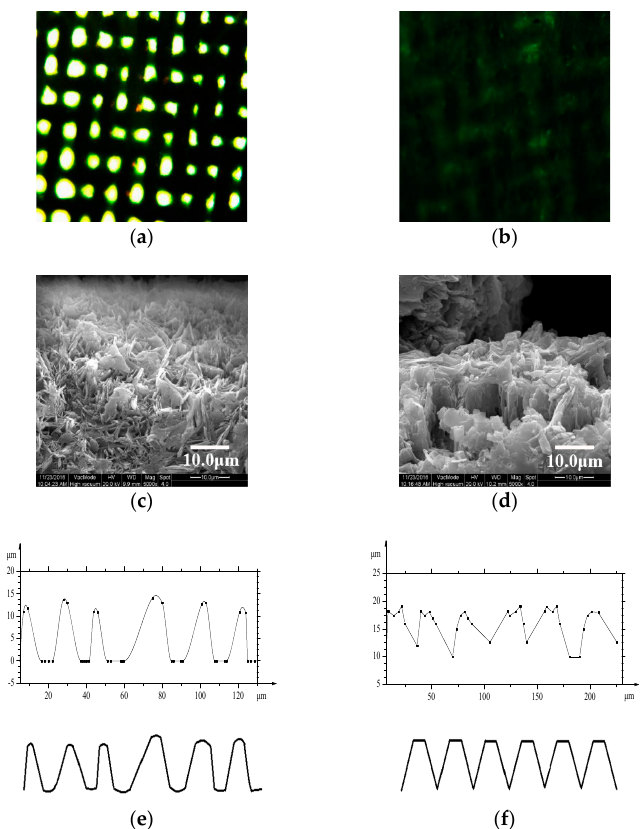
Figure 4. Copper mesh morphology after etching, oxidation, and modification with SA under microscope and SEM: ( a , c ) unground; ( b , d ) ground; ( e ) the fitting curve of Figure 4c; ( f ) the fitting curve of Figure 4c.